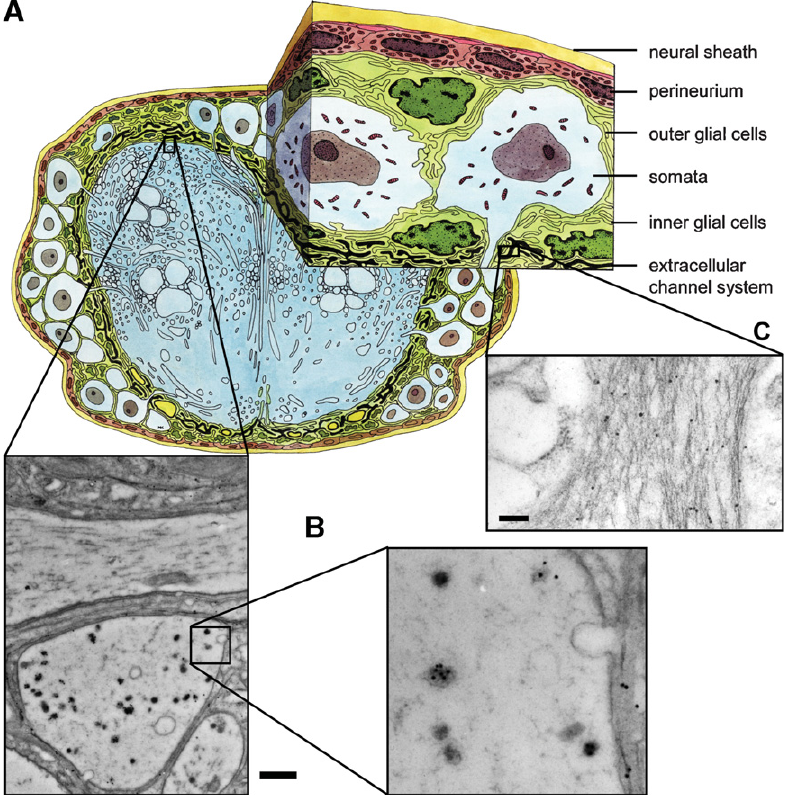
Figure 3. PSK immunostaining in the neuropile and the extracellular matrix . ( A ) Schematic drawing of a cross-section through the sixth AG. ( B , C ) PSK- ir shown by immuno-gold technique occurs in axons of the neuropile (B) and in the channel system of the extracellular matrix (C). Bars, 1 m m (B), 250nm (C)